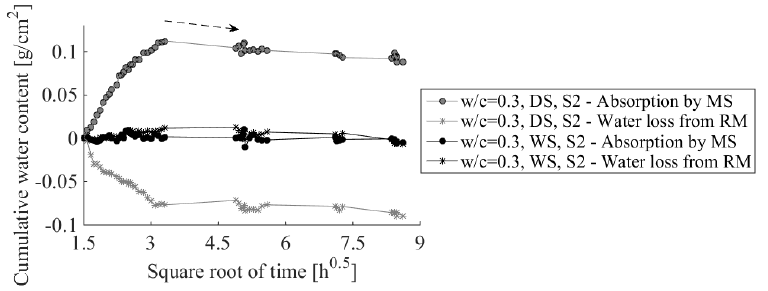
w/c = 0.3, DS, S3; ( b ) wet substrate, w/c = 0.3, WS, S3; and ( c ) legend.